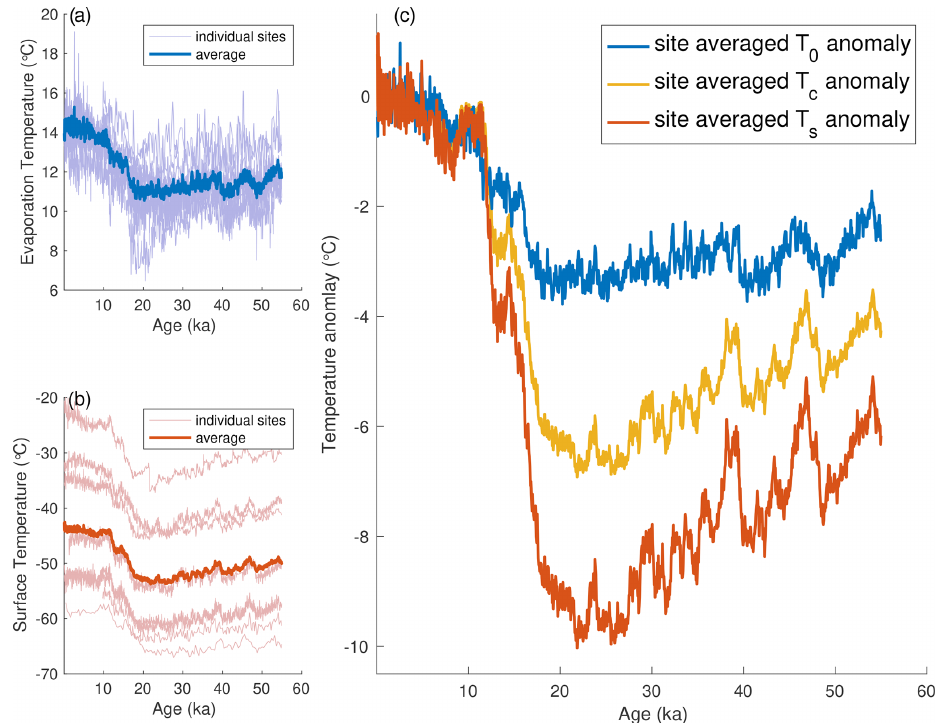
Figure 13. Antarctic-wide stacks of reconstructed temperature histories. (a) Moisture source evaporation temperatures, T 0 , of all ice-core sites are shown in light blue, while the average of all records is shown in dark blue. (b) All reconstructions of ice-core site surface tem- peratures, T s , are shown in light red, while the continent-wide average is shown in dark red. (c) Anomalies of site-averaged evaporation temperature (blue), condensation temperature (gold), and surface temperature (red) are shown with respect to the mean value of the most recent 2000 years. All records are interpolated to even 50-year spacing. Where possible records are on the synchronized Buizert et al. (2018)